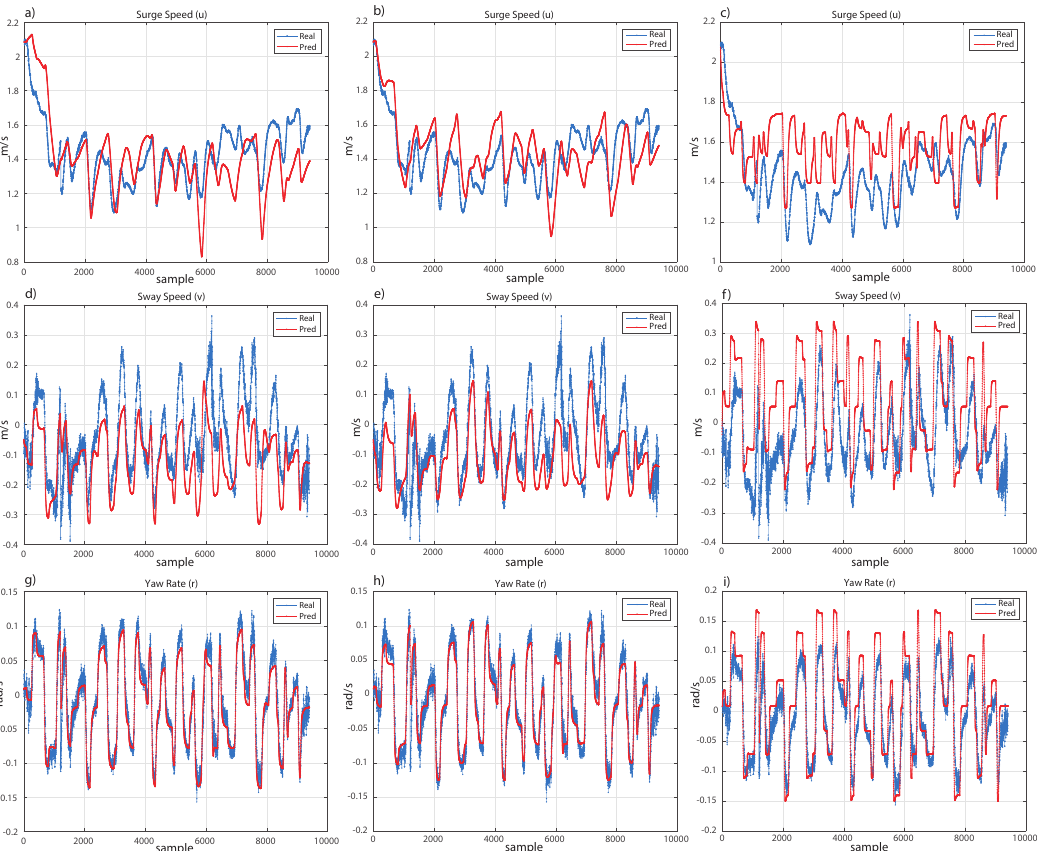
Figure 7. Validation set for the best models with the polynomial kernel ( a ) surge speed, ( d ) sway speed, ( g ) yaw rate; SR ( b ) surge speed, ( e ) sway speed, ( h ) yaw rate; and SOA-SR ( c ) surge speed, ( f ) sway speed, ( i ) yaw